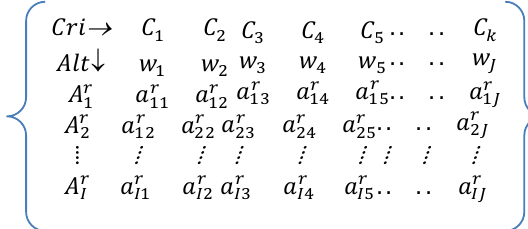
Table 7. Pairwise comparison matrix (Factor and Criteria)